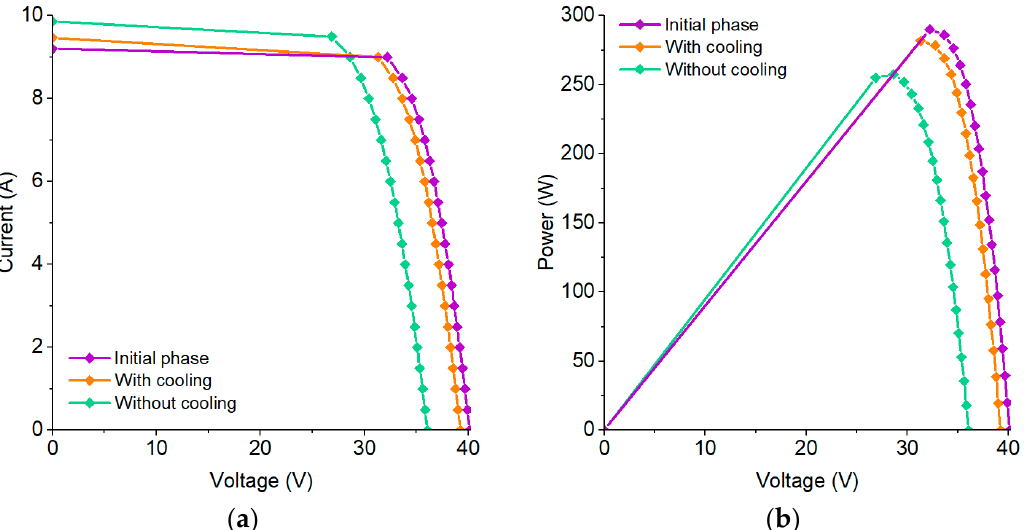
Figure 13. Variations in the performance of the 310 Wp PV panel depending on its temperature: I-V characteristic ( a ) and P-V characteristic ( b ).